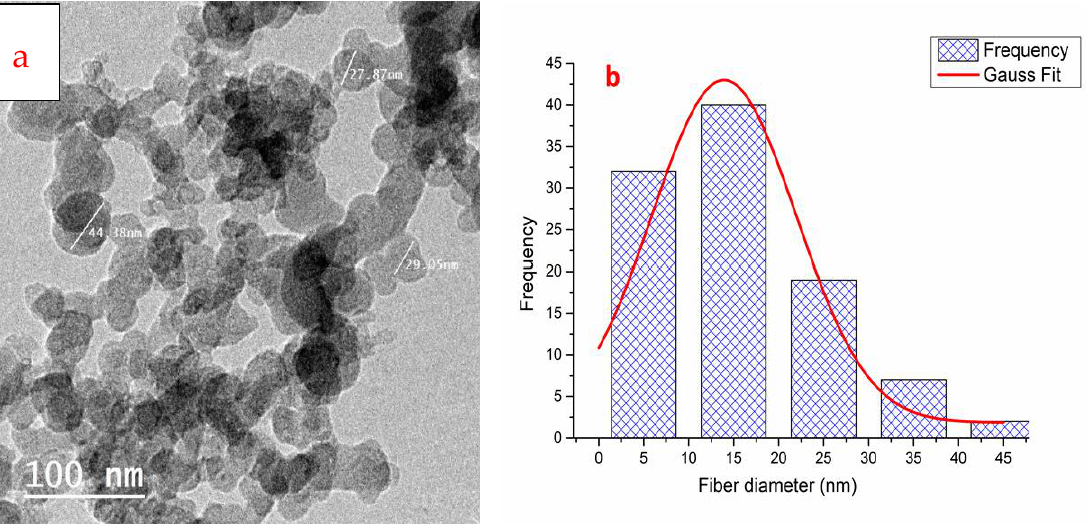
Figure 3. TEM image ( a ); histogram of the particle size distribution of synthesized chitosan nanoparticles (CSNPs) using a chitosan concentration of 0.2 weight percent and 0.1 weight percent TPP for 45 min ultrasonication and a pH value of 5.5 (b).